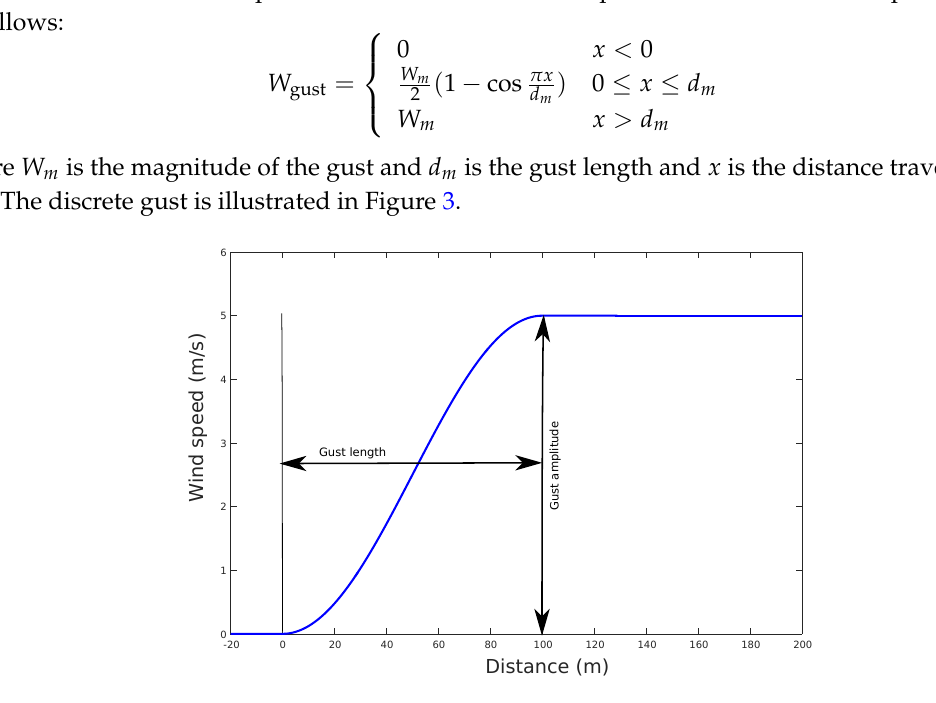
Figure 3. Typical discrete gust profile that shows a growth over the wind on a short period of time from the initial wind speed of the gust magnitude, and a permanent increase at the end of the gust